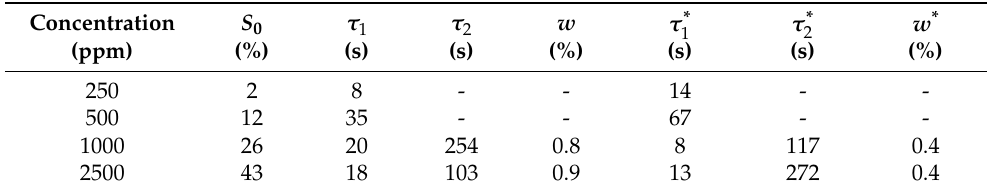
Table 2. Results of the fitting procedure for the response and recovery transients with various concentrations of NO at the temperature of 350 ◦